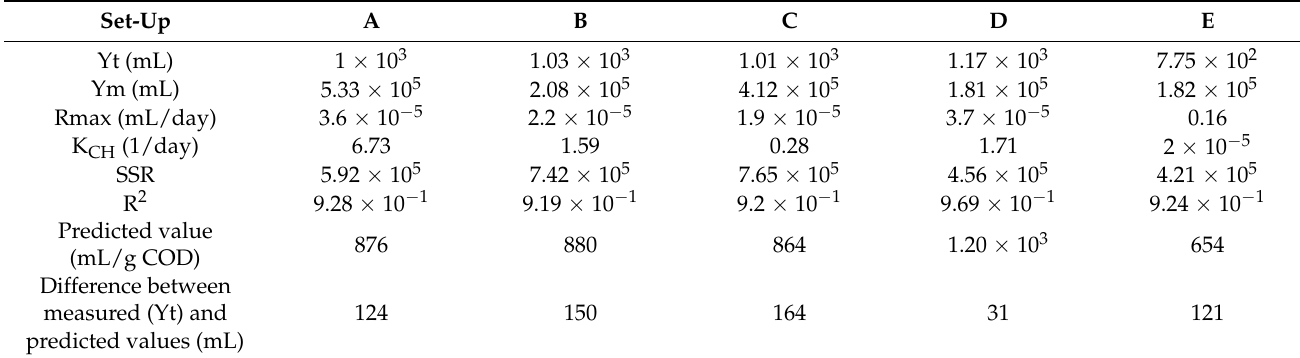
Table 7. Summary of the Chen and Hashimoto kinetic model for bioreactors